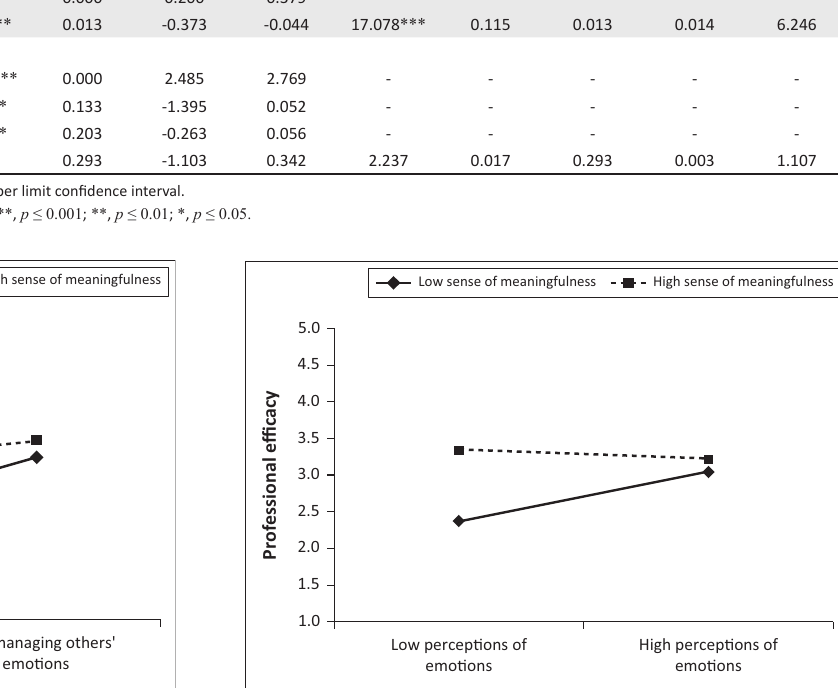
FIGURE 4: Interaction effect (perceptions of emotions x sense of meaningfulness) in predicting exhaustion.